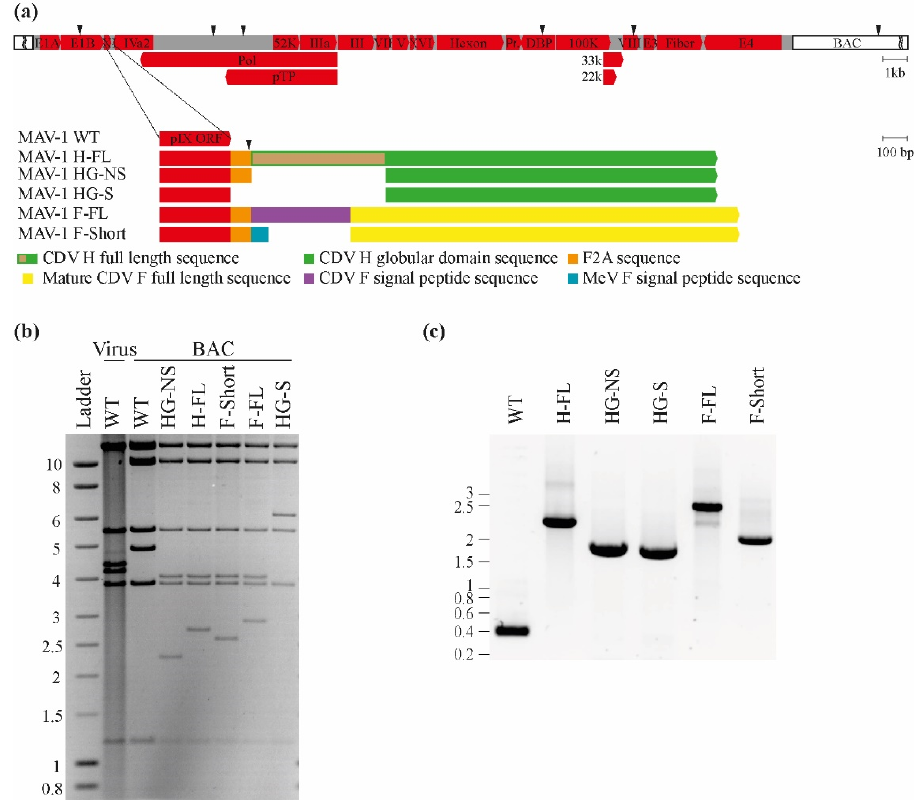
Figure 1. Construction and characterization of MAV-1 recombinant expressing CDV antigens. ( a ) Schematic representation of the strategies used to produce the recombinant MAV-1 strains. The MAV-1 genome is represented from 5 (cid:48) to 3 (cid:48) in a Bacterial Artificial Chromosome (BAC). Black ar- rowheads indicate Apa I restriction sites. ( b ) Verification of the molecular structures. Viral DNA and BAC DNA were isolated and digested with Apa I. The restriction fragments were then separated by electrophoretic migration and revealed by ethidium bromide and UV exposure. Pr.: protease. Marker sizes in Kbp are indicated on the left. ( c ) PCR amplification of the region encompassing the insertion site. The PCR products were separated by electrophoretic migration and revealed by ethidium bromide and UV exposure. Marker sizes in Kbp are indicated on the